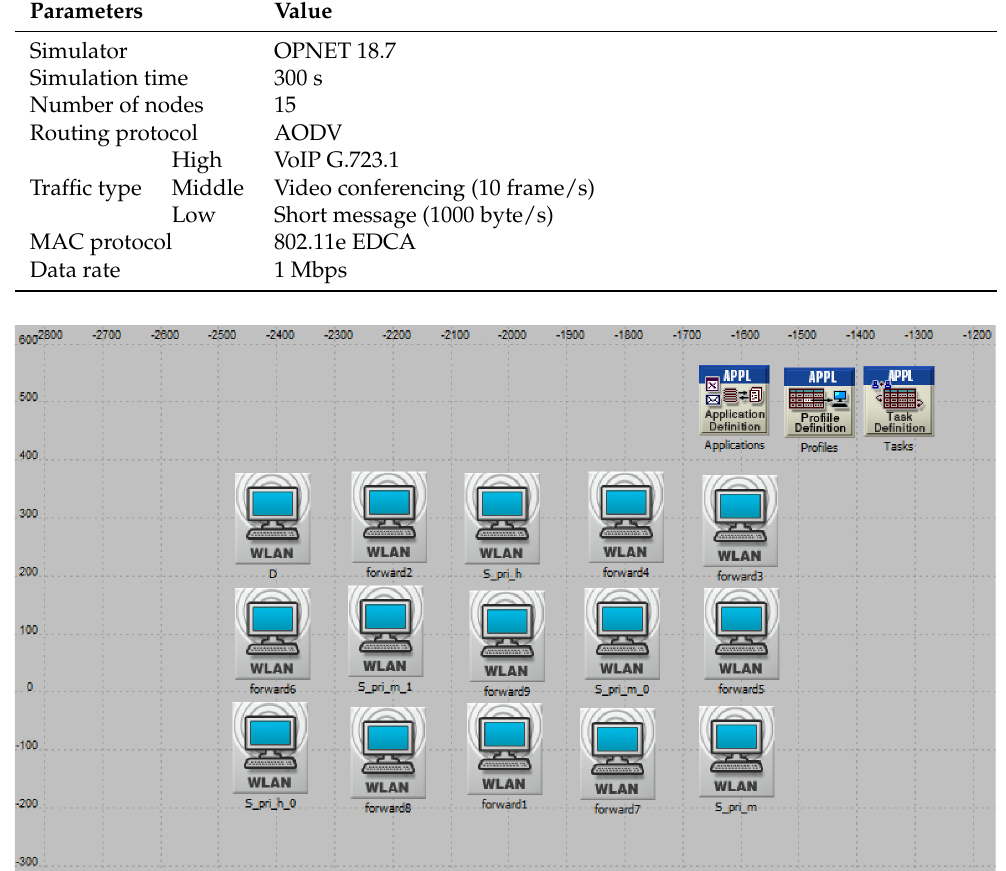
Figure 8. Node configuration in